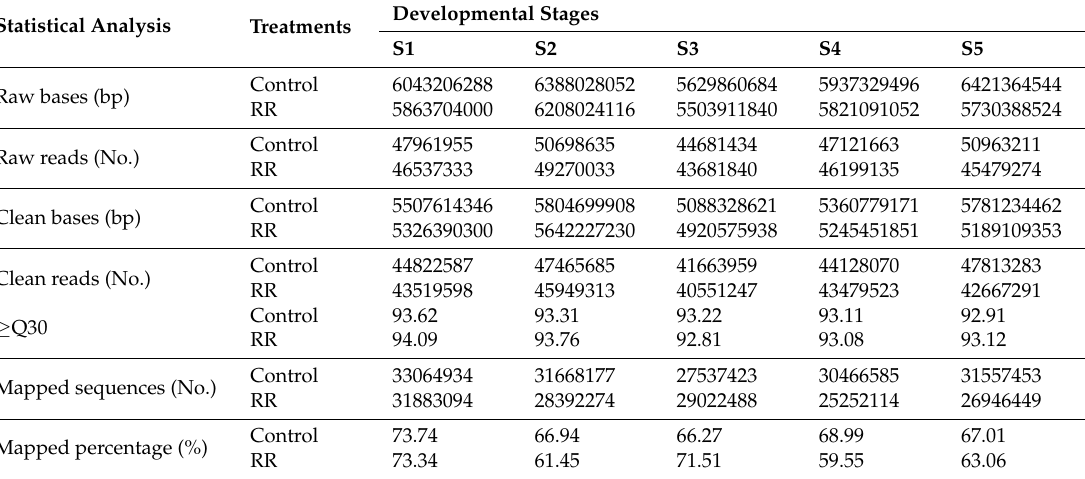
Table 1. Summary of sequencing data and statistics of the transcriptome assembly during developmental stages.